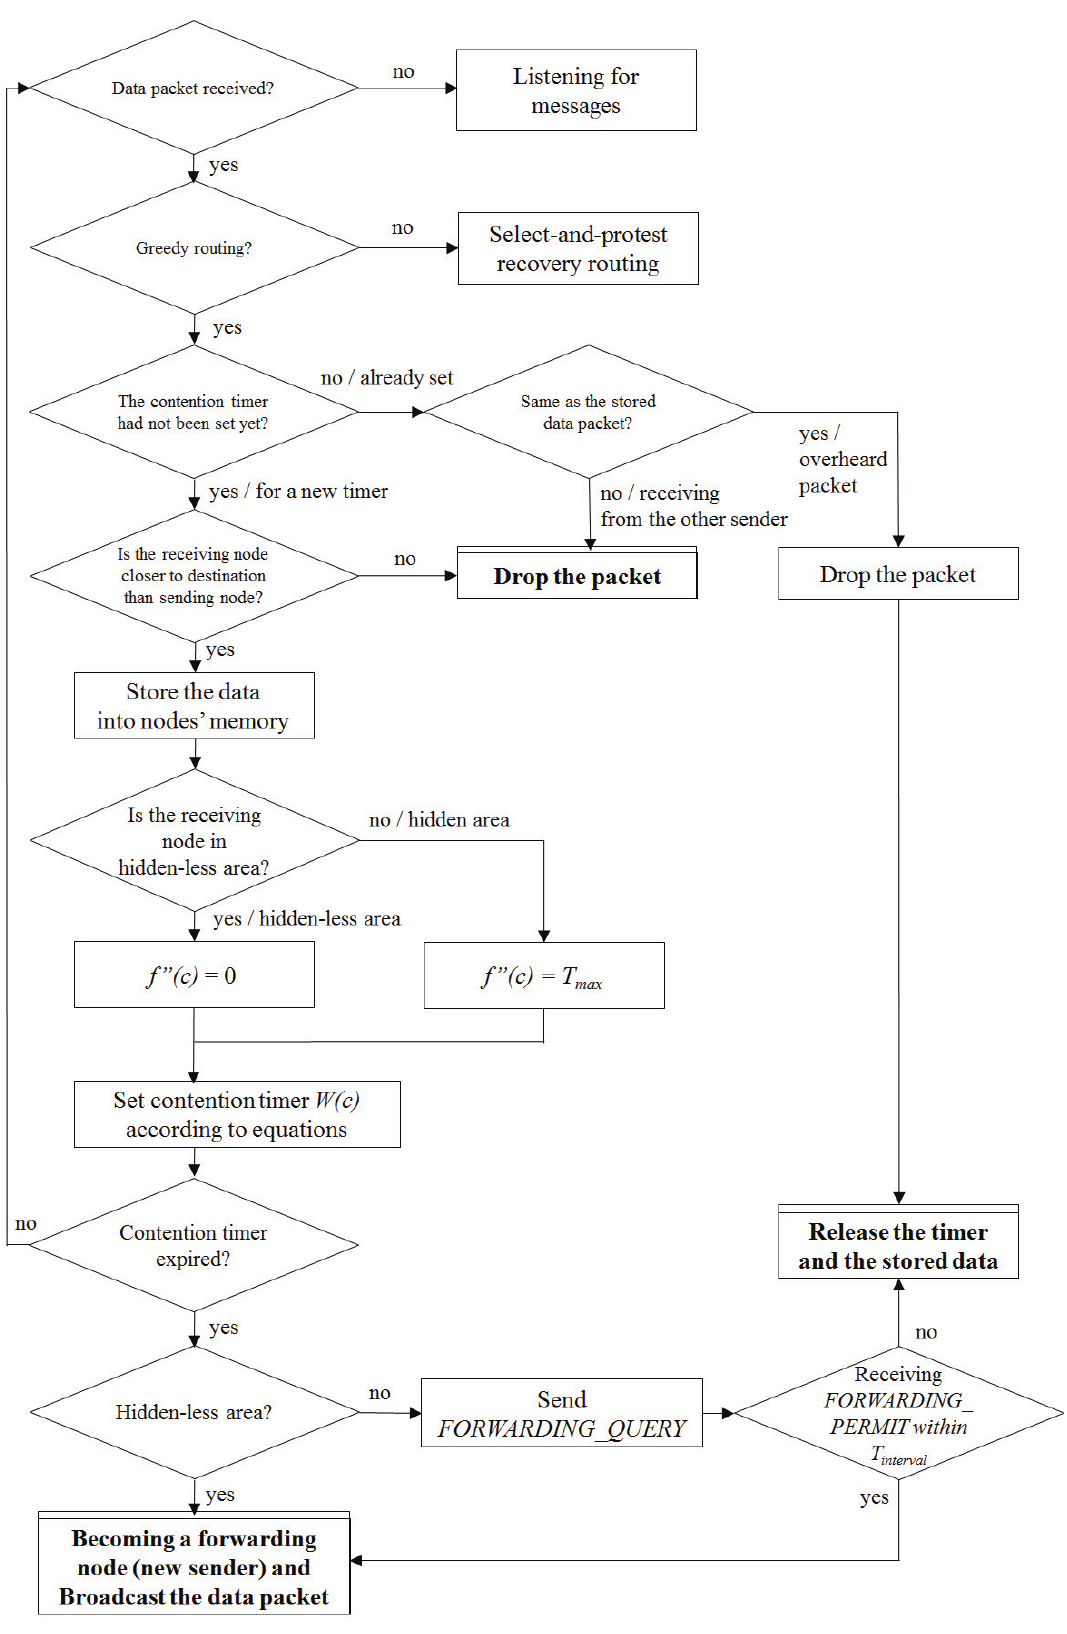
Figure 4. The flowchart of the receiver